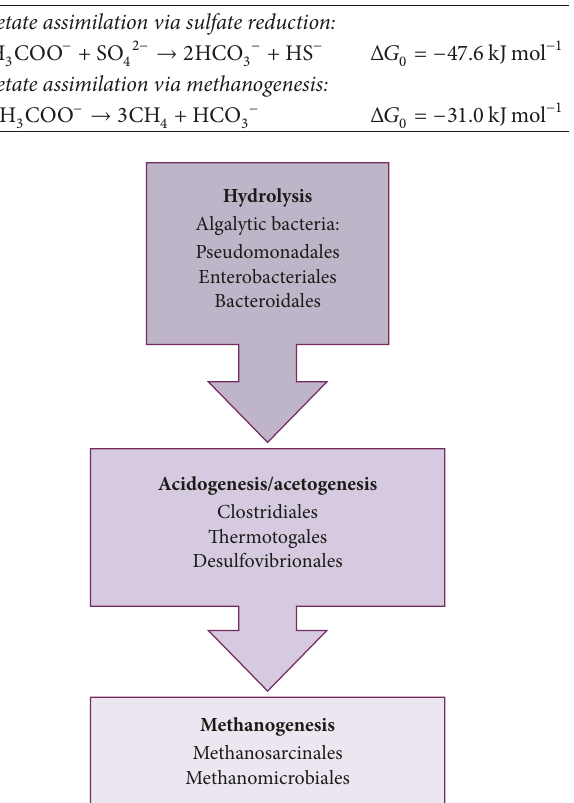
Table 3: Free Gibbs energy required for the assimilation of acetate via sulfate-reduction and methanogenesis [31].